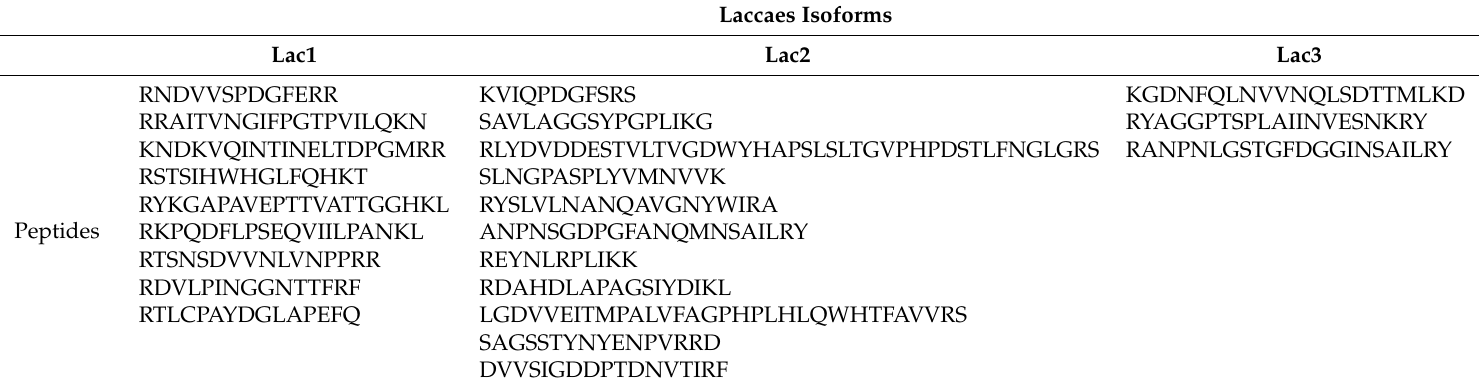
Table 4. Peptide sequences matching reported laccases after HPLC-LTQ-Orbitrap-MS following trypsin